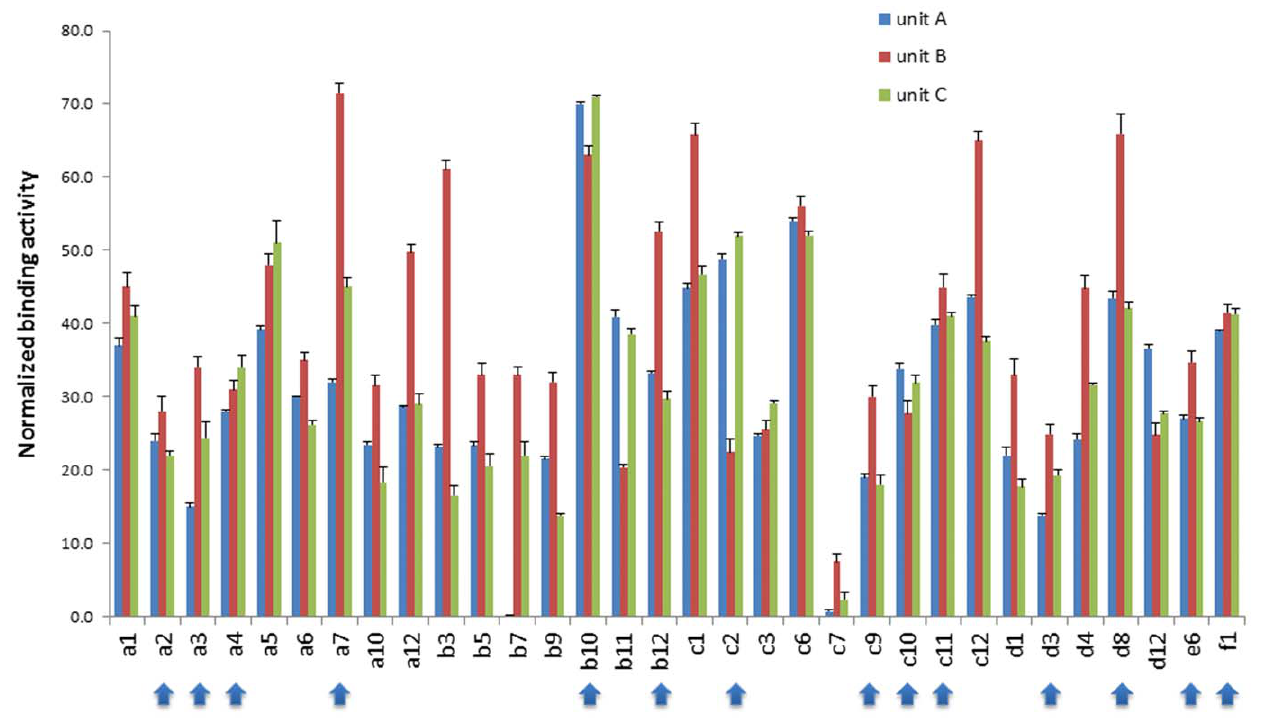
Figure 4. Binding of selected monoclonals to different Ag85 subunits. Each of the individual antibodies was tested for binding to the complete Ag85 complex, and the values obtained used to normalize the recognition of the 48 different scFvs for the three different Ag85 components. The arrowed clones were taken for further testing.